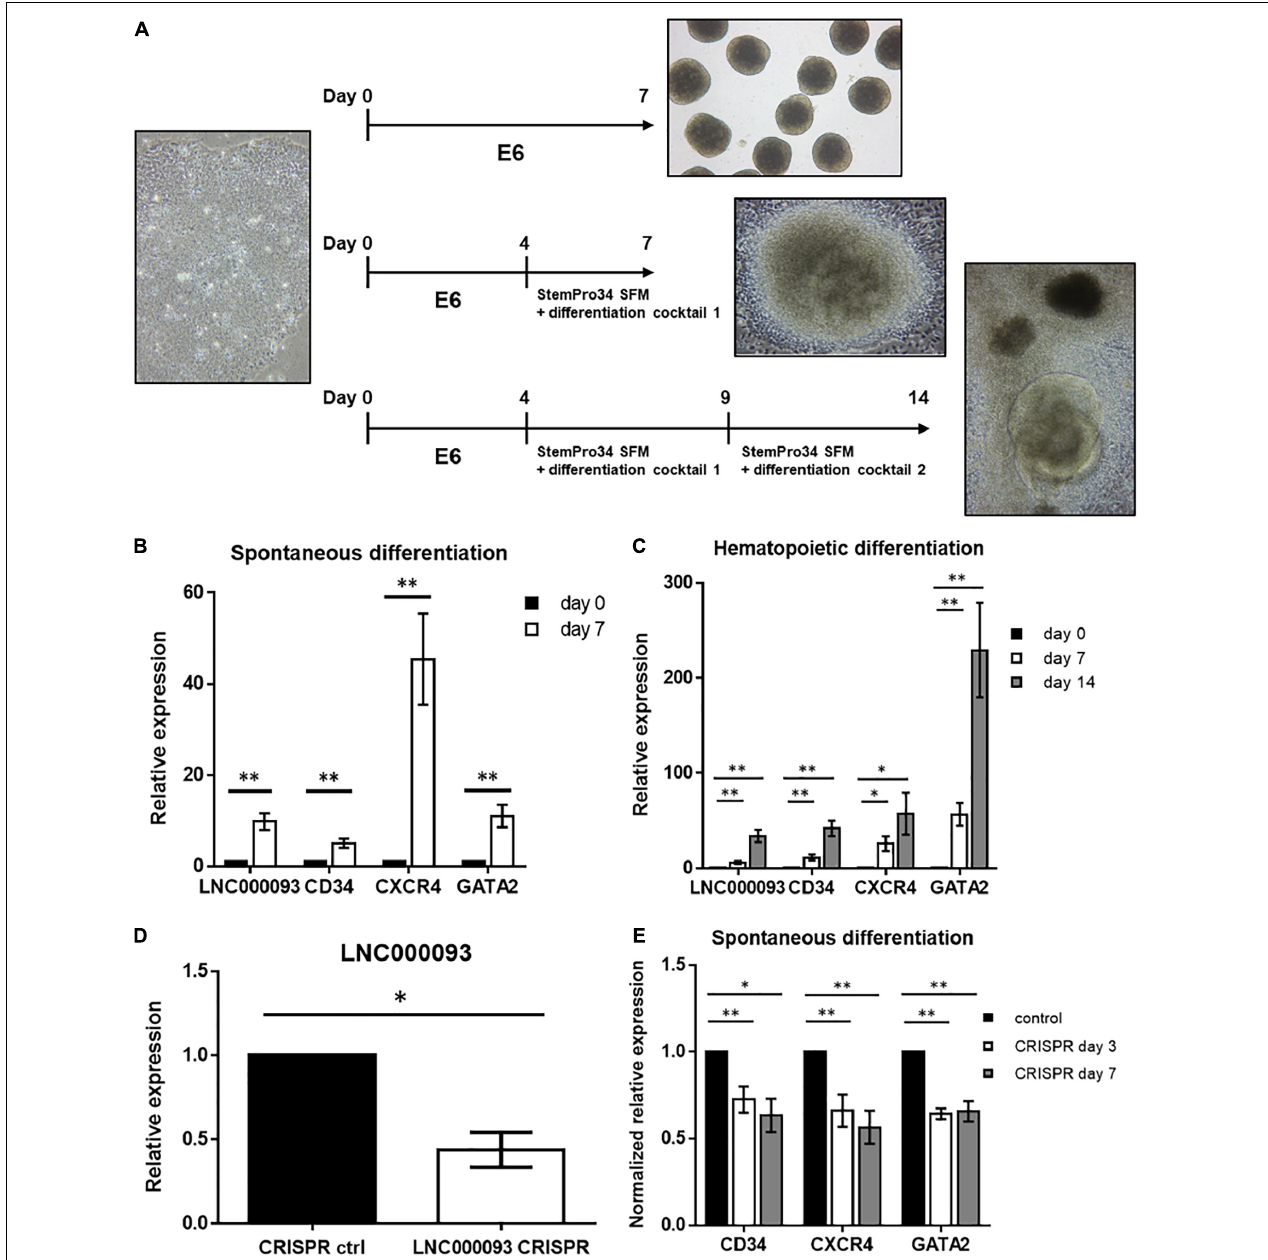
FIGURE 5 | Potential role of LNC000093 in hematopoietic differentiation. (A) A schematic diagram of the culture protocol for three different iPSC differentiation schedules. (B,C) RT-qPCR analysis showed upregulation of LNC000093, CD34, CXCR4, and GATA2 expression upon (B) 7-day spontaneous differentiation ( n = 4), and (C) 7- and 14-day hematopoietic differentiation ( n = 6). The mean ± SEM is shown for the results. ∗ P < 0.05, ∗∗ P < 0.01. (D) The expression level of LNC000093 after CRISPR-deletion in iPSC was evaluated by RT-qPCR ( n = 3). The mean ± SEM is shown for the results. ∗ P < 0.05. (E) RT-qPCR analysis revealed a reduced relative expression change of CD34, CXCR4, and GATA2 in 3-day and 7-day LNC000093-CRISPR-deleted EB with normalization to control EB ( n = 6). The mean ± SEM is shown for the results. ∗ P < 0.05, ∗∗ P < 0.01.